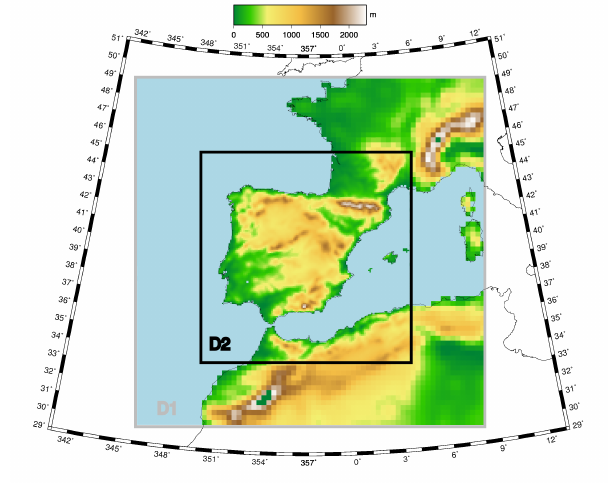
Figure 1. RCM spatial domains. Mother domain, D1 (30 km), and inner domain, D2 (10 km). Topography of the spatial domains.